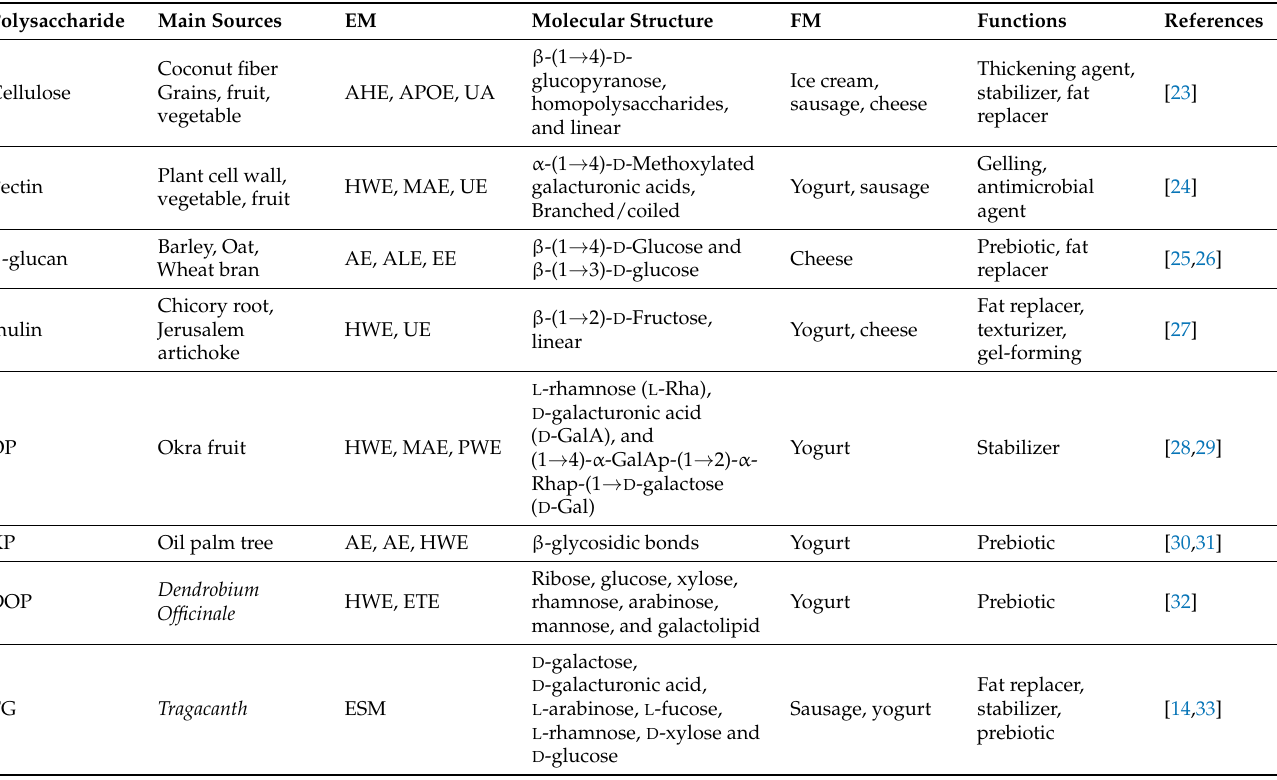
Table 1. Plant polysaccharides used in fermented